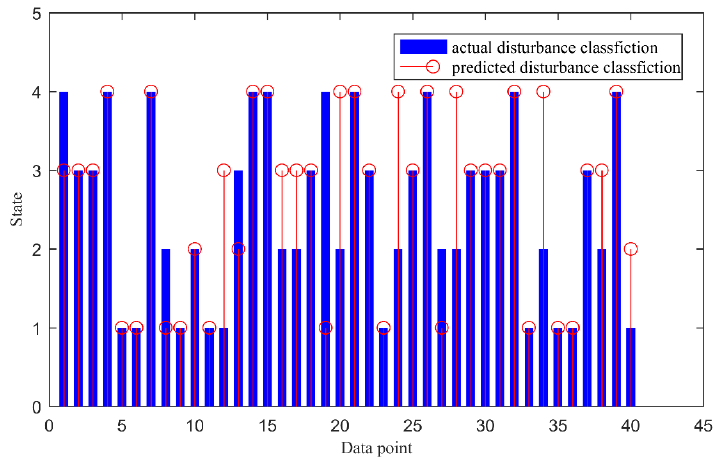
Figure 30. The BP classification diagram of the value of the components decomposed by EEMD calculated by CMFE. Table 7. BP classification parameters of the three algorithms. State